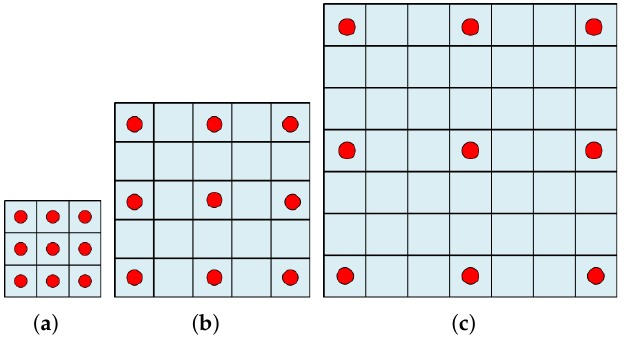
Figure 1. The dilated convolution with a different dilated factor. ( a ) denotes the dilated convolution with 𝑟 = 1. ( b ) denotes the dilated convolution with 𝑟 = 2. ( c ) denotes the dilated convolution with 𝑟 =